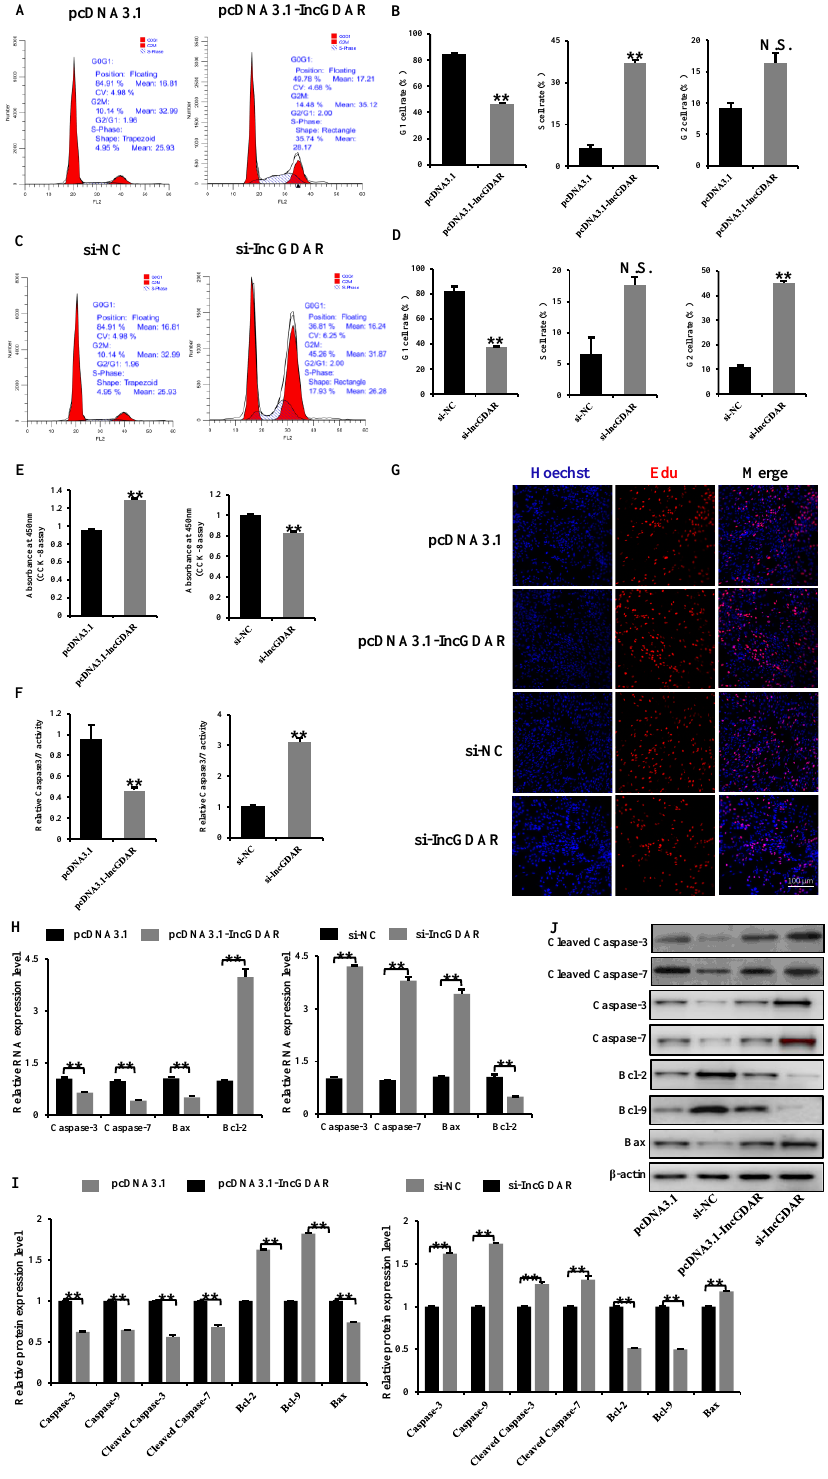
Figure 7. Mechanism study of lnc GDAR regulation of GC apoptosis. ( A , B ) Cell cycle analysis of GCs at 48 h after transfection of pcDNA3.1-lnc GDAR and pcDNA3.1 empty plasmids. ( C , D ) Cell cycle